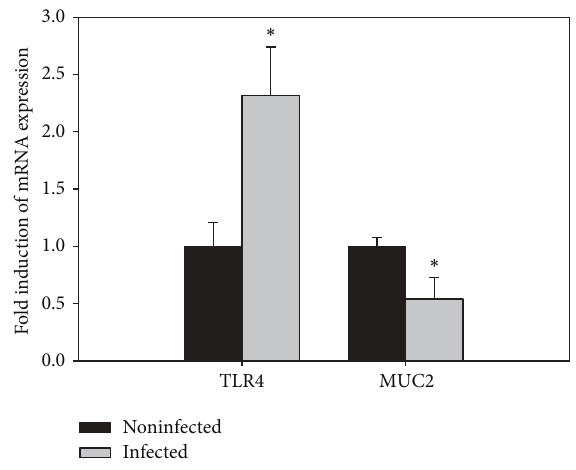
Figure 5: Quantitative RT-PCR analysis of TLR4 and MUC2 in the jejunum. Expression was analyzed in non-infected and infected mice on day 5 p.i., normalized to 18S rRNA signals, and relative expression is given as fold increase compared to the non-infected control mice. Values are means ± SD. ∗ Significant change at 𝑃 < 0.01 with respect to noninfected